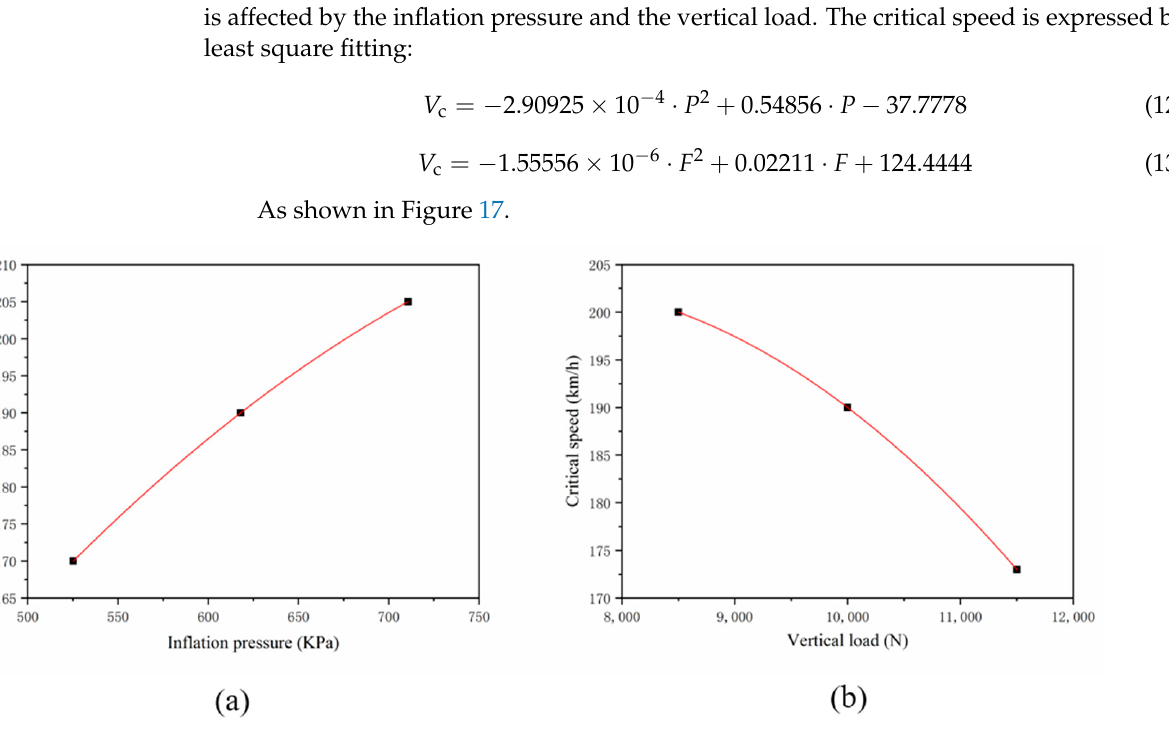
Figure 17. Critical speed vs. ( a )inflation pressure and ( b )vertical load.